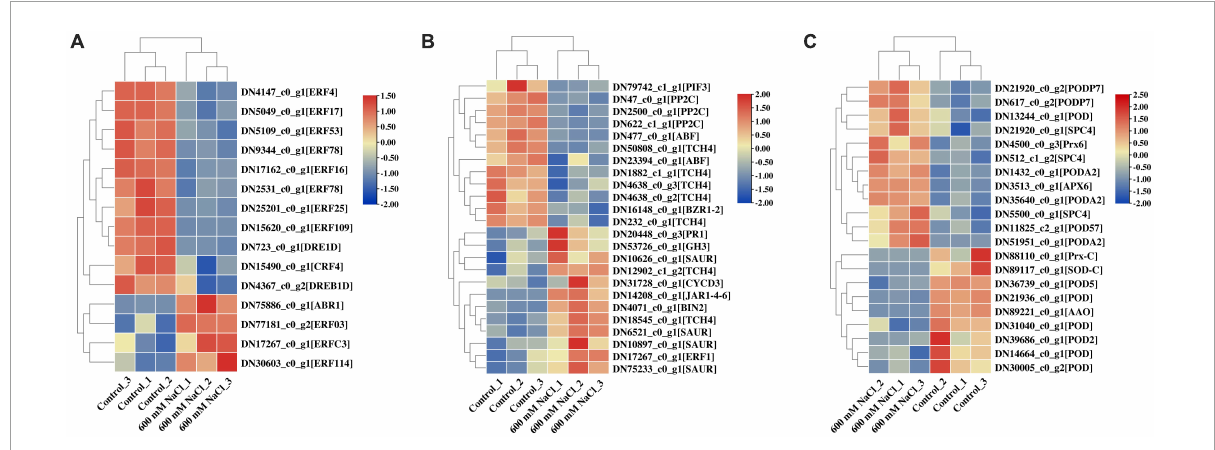
FIGURE8 Heatmap analysis of AP2 gene family (A) , plant phytohormones (B) , and antioxidant activity (C) related to DEGs in the leaves of S. portulacastrum under high